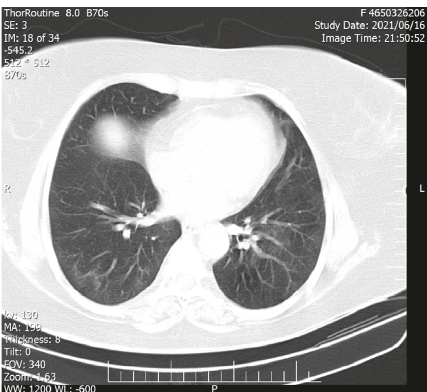
Figure 3: Diffuse ground-glass opacities in both the lungs com- patible with the convalescent pulmonary phase of SARS-CoV-2